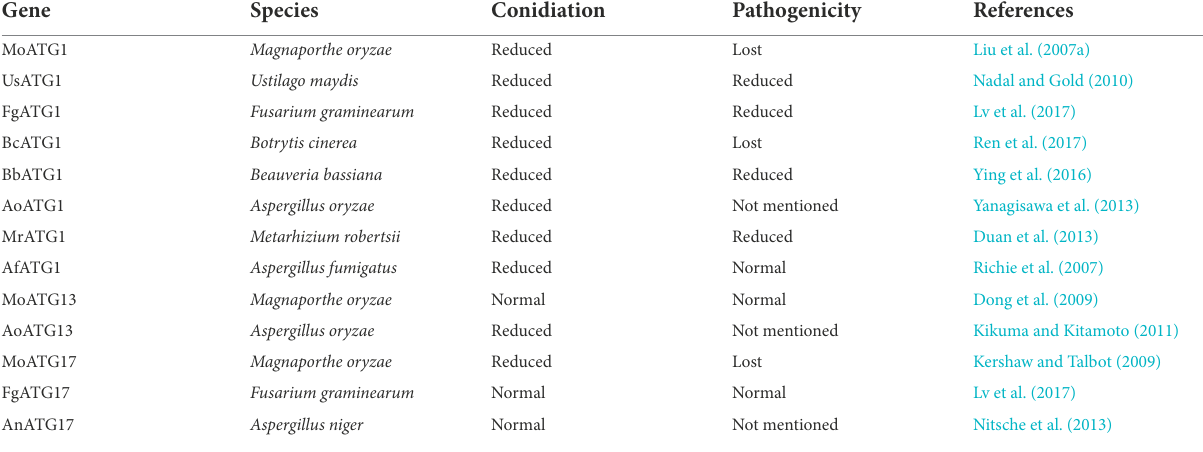
TABLE 1 Atg1 complex related to pathogenicity in pathogenic